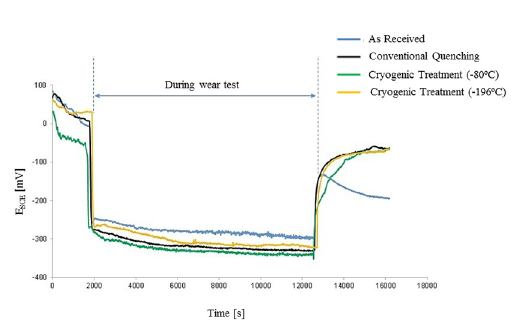
Figure 15: Open circuit potential monitoring results before, during and after wear